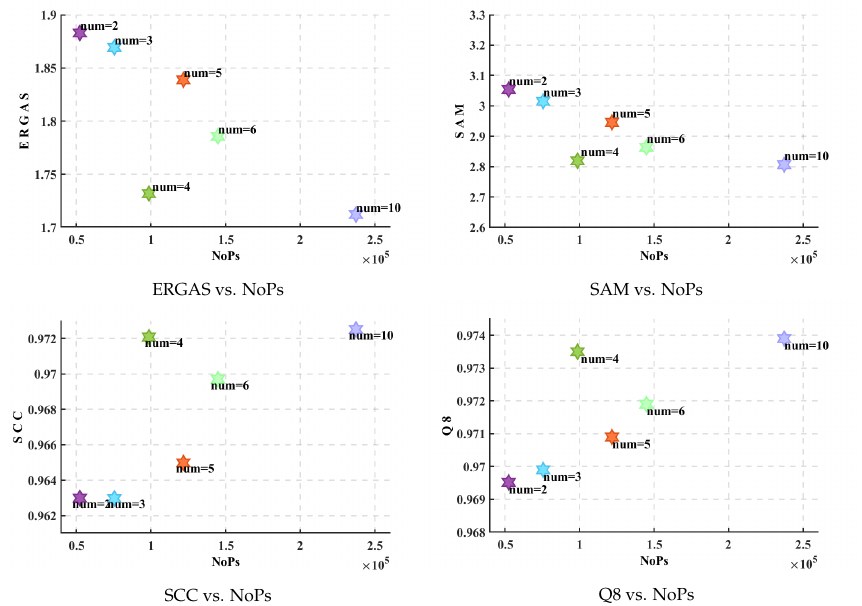
Figure 15. Number of parameters (NoPs) report and quantitative comparison of the number of PFFBs on the Rio dataset.